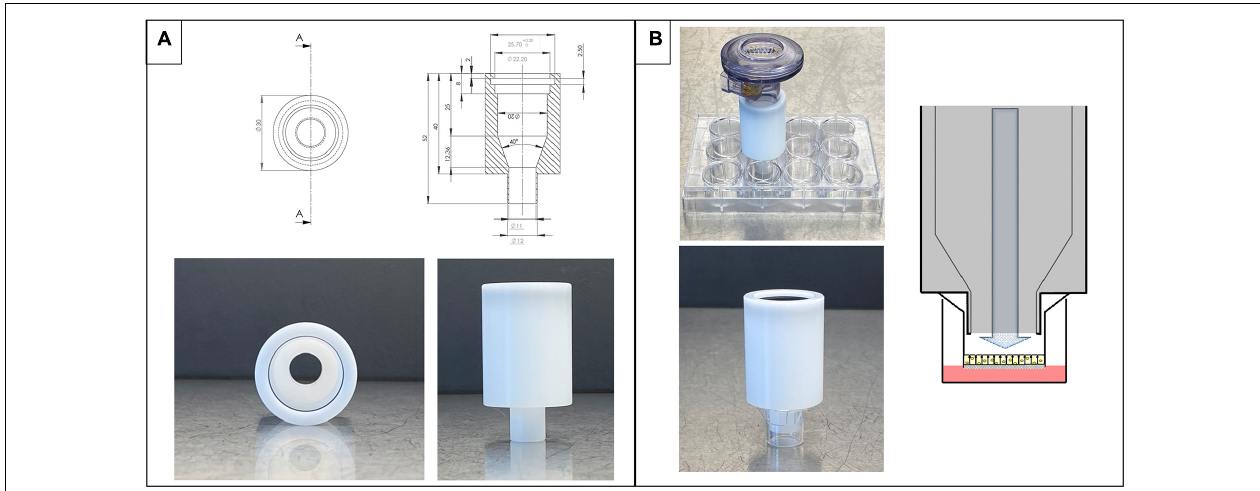
FIGURE 1 | Design and dimensions of the deposition system. (A) Technical drawing and images of the device alone. (B) Nebulizer connected to deposition device on top of Transwell R (cid:13) inserts ready for nebulization on cells (top image) and details of placement in an insert (bottom). On the right side, schematic view of the process of nebulization in a Transwell R (cid:13)